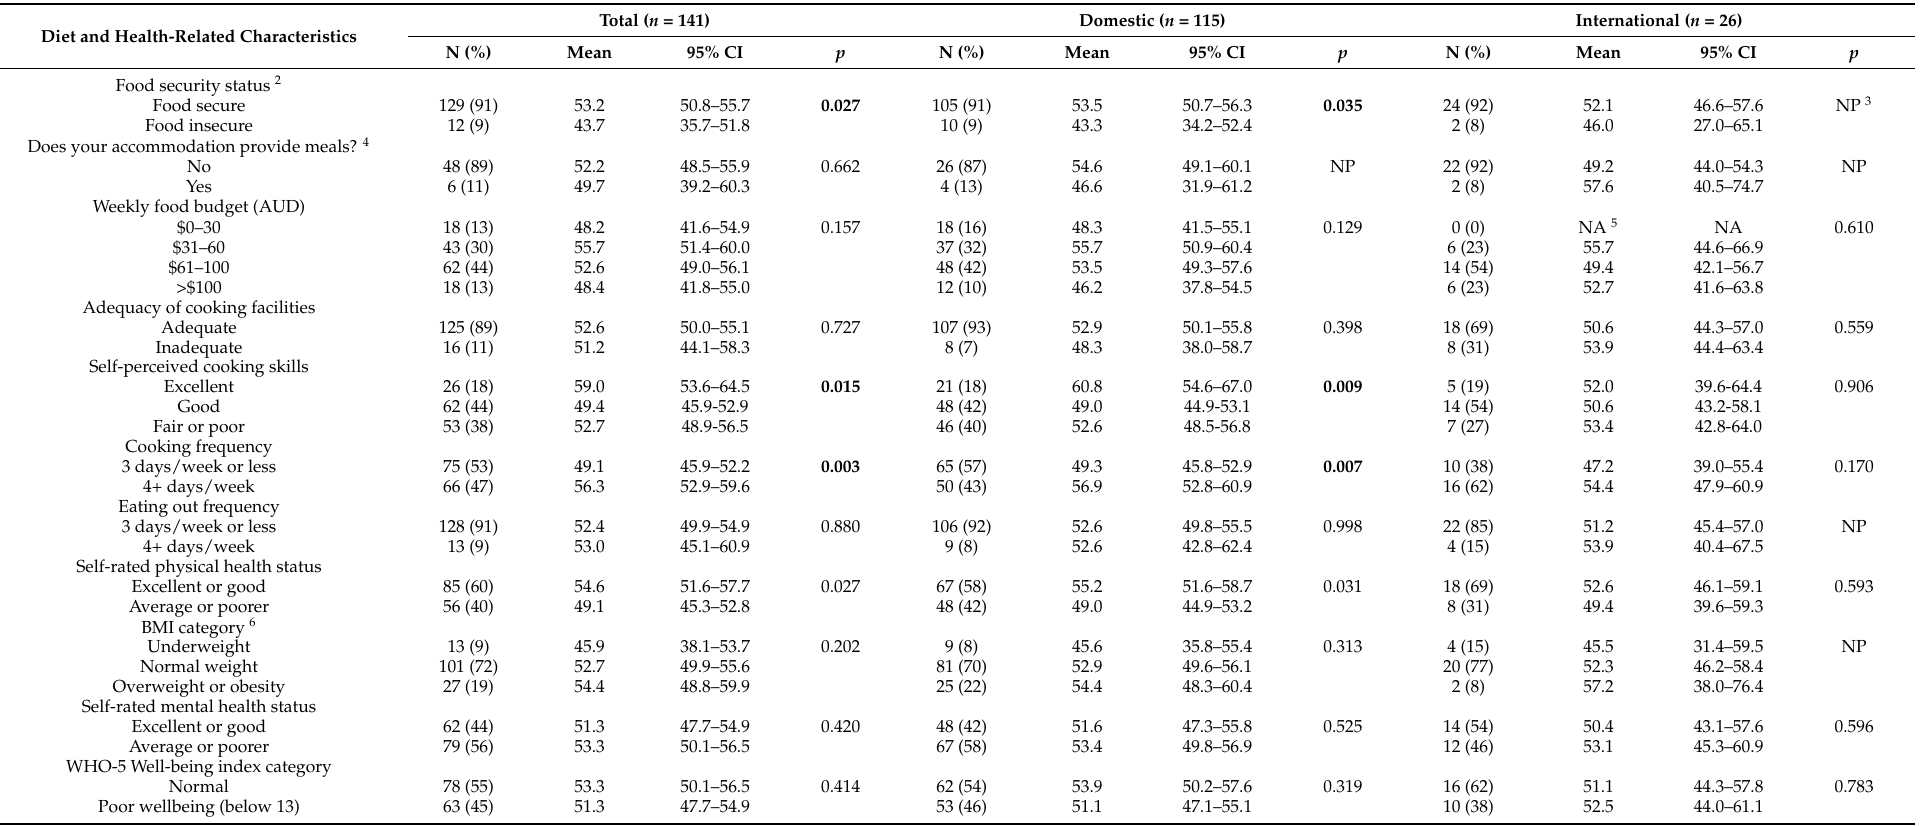
Table 3. Mean scores of Healthy Eating Index for Australian Adults (HEIFA-2013) by diet and health-related characteristics from domestic and international students attending a large Australian university. 1